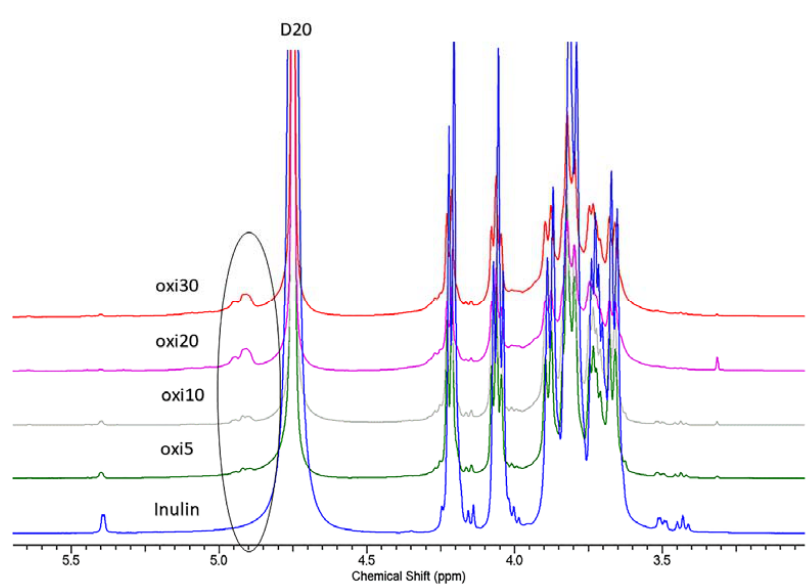
Figure 10. 1 HNMR of oxidized inulin (oxi5).